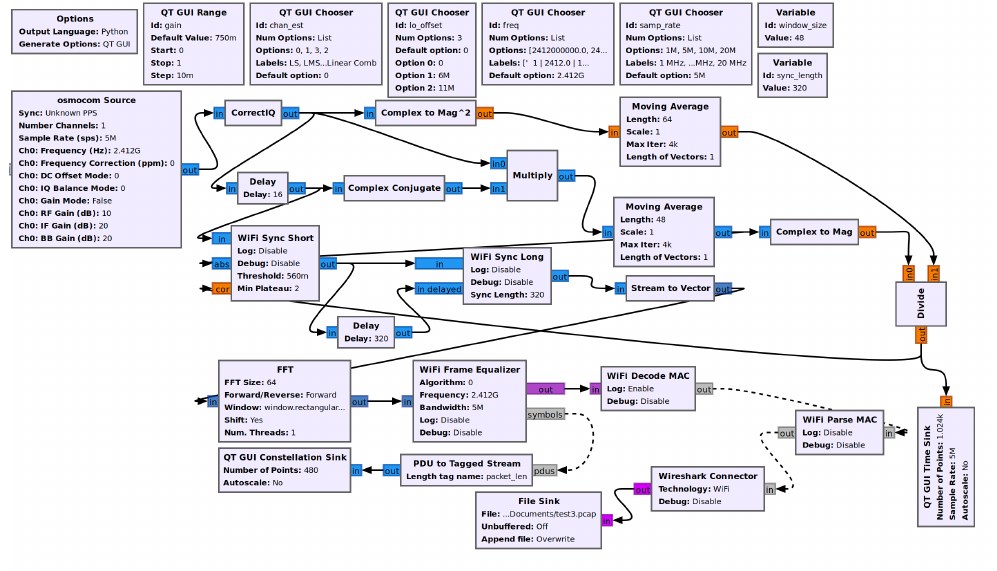
Figure 11. GNU Radio receiver program flowchart for 802.11p. The 802.11p messages are received through the HackRF One using the oscmocom source and decoded; resulting information and messages are saved to a pcap file for reading in